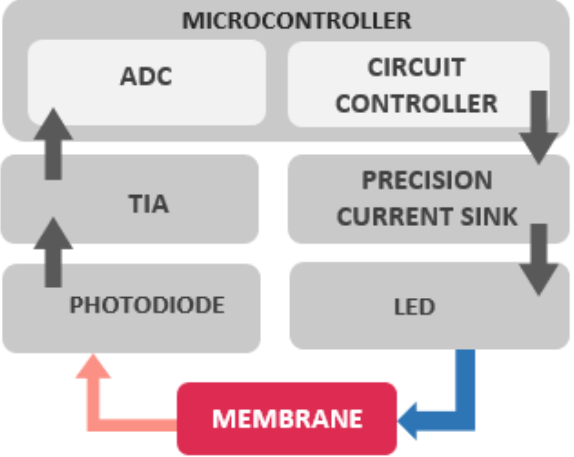
Figure 4. Brief description of hardware blocks.